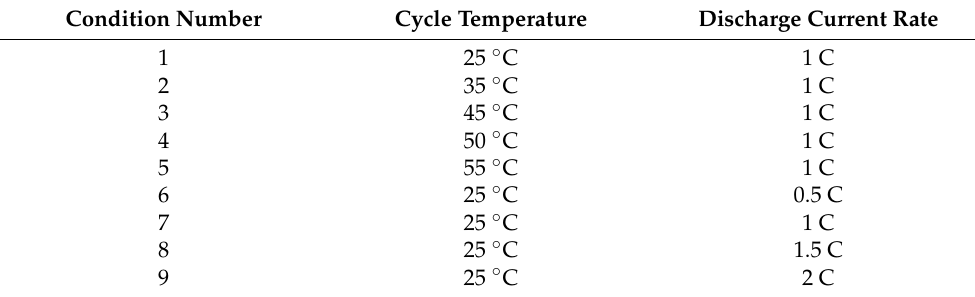
Table 2. Cycle life conditions of Battery I.